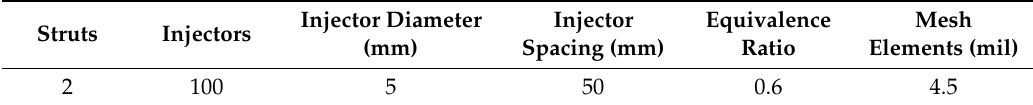
Table 8. 3-D scramjet integration final setup.